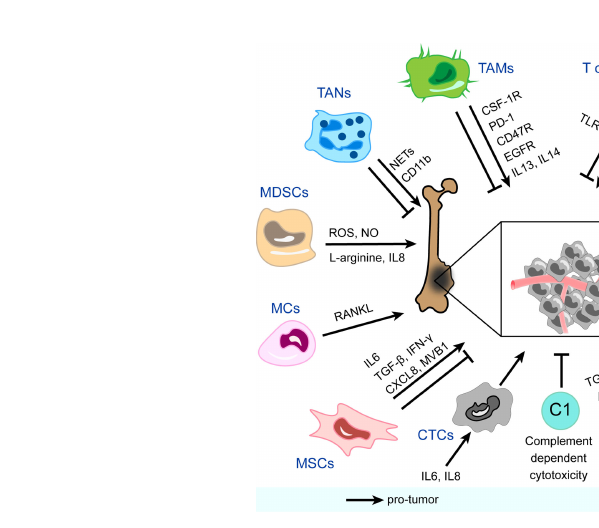
FIGURE 1 | Immune and non-immune components in the immune microenvironment of osteosarcoma and mechanisms of their pro-tumor/anti-tumor effects. CSF-1R, colony-stimulating factor 1 receptor; PD-1, programmed cell death protein-1; EGFR, epidermal growth factor receptor; IL, interleukin; NETs, neutrophil extracellular traps; ROS, reactive oxygen species; NO, nitric oxide; RANKL, receptor activator NF- k B ligand; TGF- b , transforming growth factor-beta; IFN- g , interferon-gamma; CXCL8, C-X-C motif chemokine ligand 8; AFP, a -fetoprotein; HSP, heat shock protein; TIM-3, T cell immunoglobulin and mucin domain- containing protein-3; OAA, osteosarcoma-associated antigens; PD-L1, programmed cell death protein ligand-1; GRM4, glutamate metabotropic receptor 4; CCR7, chemokine receptor 7; TNF- a , tumor necrosis factor-alpha; CTLA-4, cytotoxic T-lymphocyte-associated protein-4; BTLA, B And T-lymphocyte attenuator; AIRE, autoimmune regulator expression; hSFRP2, humanized secreted frizzled-related protein 2; TLR, toll-like receptor; TAMs, tumor-associated macrophages; TANs, tumor-associated neutrophils; MDSCs, myeloid-derived suppressor cells; MCs, mast cells; MSCs, mesenchymal stem cells; CTCs, circulating tumor cells; C, complement; DCs, dendritic cells; NK cells, natural killer